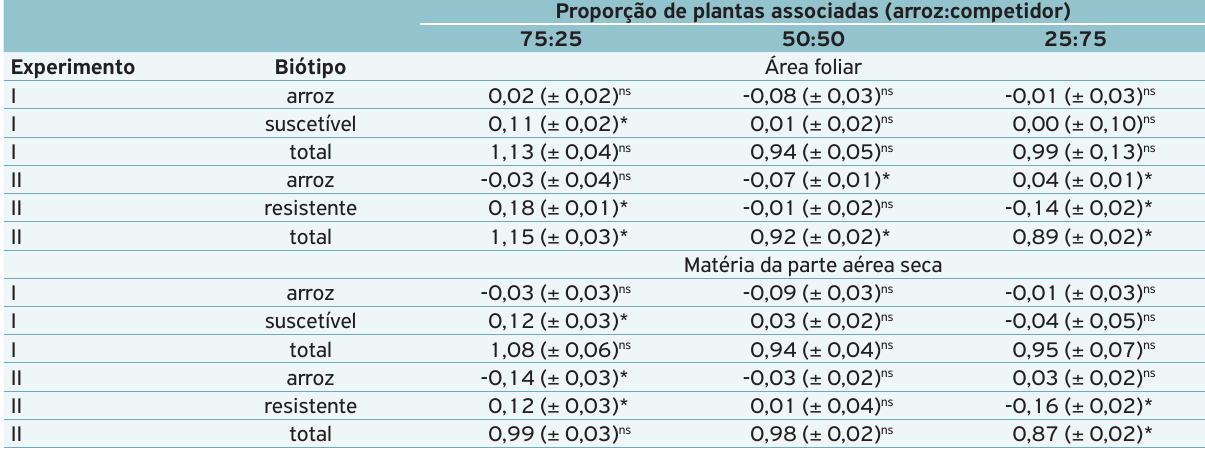
Tabela 1. Diferenças relativas de produtividade e produtividade relativa total para as variáveis área foliar e matéria da parte